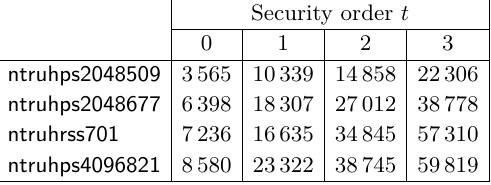
Table 7: Cycle counts for key generation (multiplicative method) for all parameters of NTRU , in thousands of cycles, on Intel(R) Core(TM) i7-1065G7 CPU @ 1.30GHz .